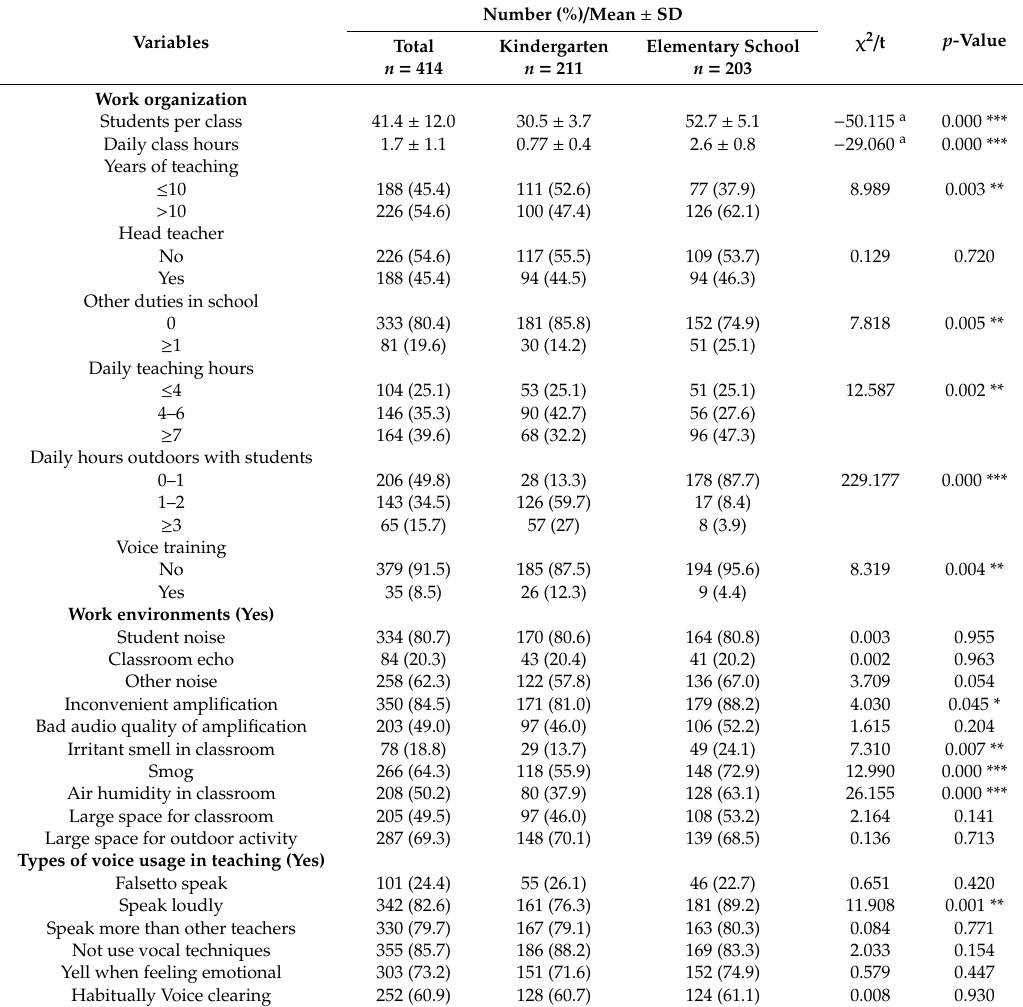
Table 3. Distribution analysis of work-related factors associated with voice disorders in early childhood teachers, Yancheng City, Jiangsu Province, China (2019), n =